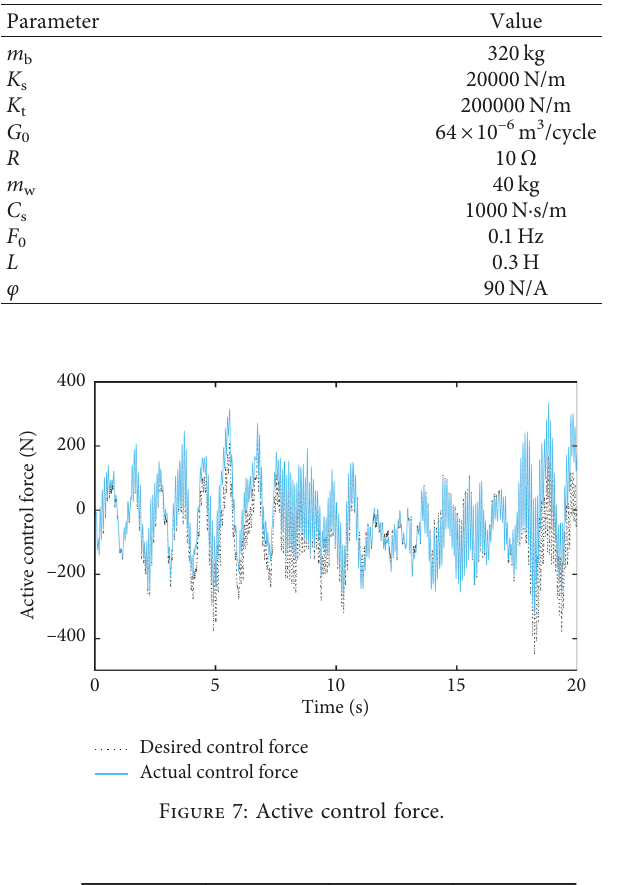
Table 1: Simulation parameters.